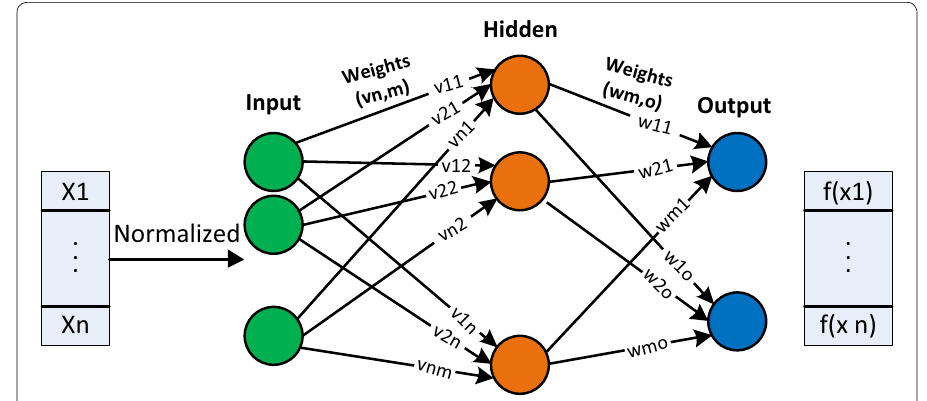
Fig. 3 Overview of a typical Artificial Neural